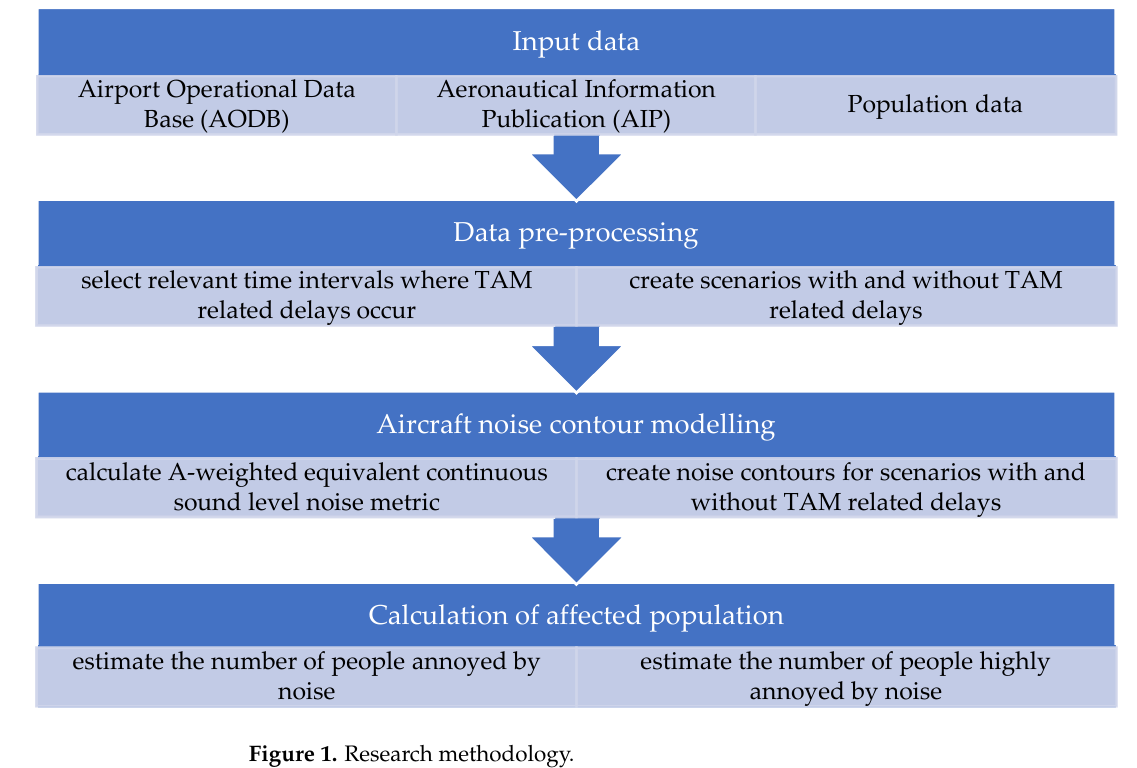
Figure 1. Research methodology.